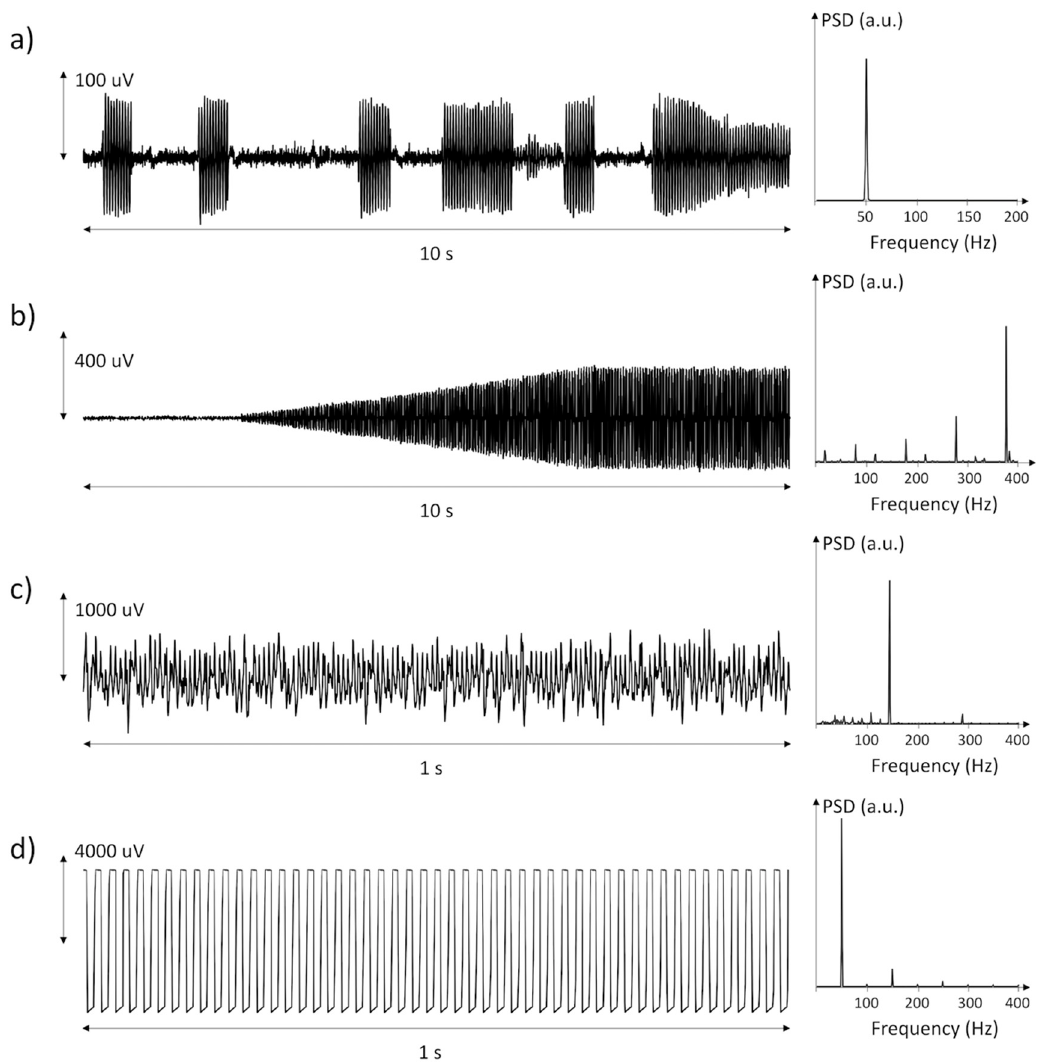
Figure 2. Three examples ( a – c ) of power line interference generated by disturbing equipment or loss of electrode–skin contact and one example ( d ) of saturation of the amplifier likely due to loss of electrode–skin contact.